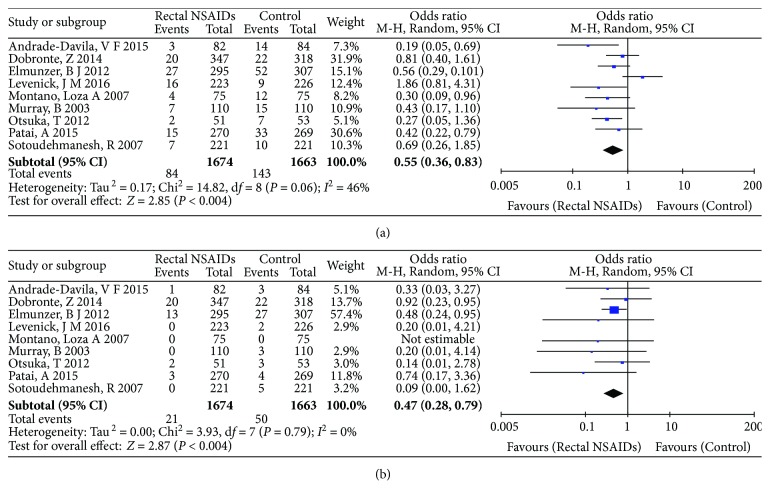
Secondary outcome: (a) forest plot showing the effect of rectal administration of NSAIDs on the incidence of mild PEP; (b) forest plot showing the effect of rectal administration of NSAIDs on the incidence of moderate-to-severe PEP.